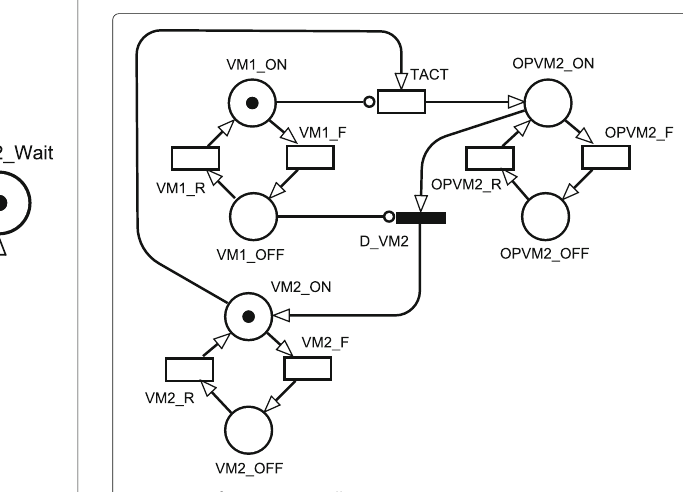
Figure 5 illustrates an SPN warm standby model. The warm standby model has an active module with a full fail- ure rate λ F ( 1/MTTF_VM1 ), and the standby is operating with a reduced failure rate α F ( 1/MTTF_OPVM1 ). This redundancy mechanism has the spare module configured, but unavailable; it also ensures that the environment has continuously mirrored data. The spare module is activated in the presence of a fault in the environment, and conse- quently the time before activation will be shorter than in the cold standby approach. When the main module fails, the secondary module is fully activated and replaces the faulty main com- ponent. The transition TACT represents the activation event. Places VM1_ON , and VM1_OFF represent the oper- ational and non-operational states of the main mod- ule. Places OPVM2_ON and OPVM2_OFF represent the spare module in the operational state when not